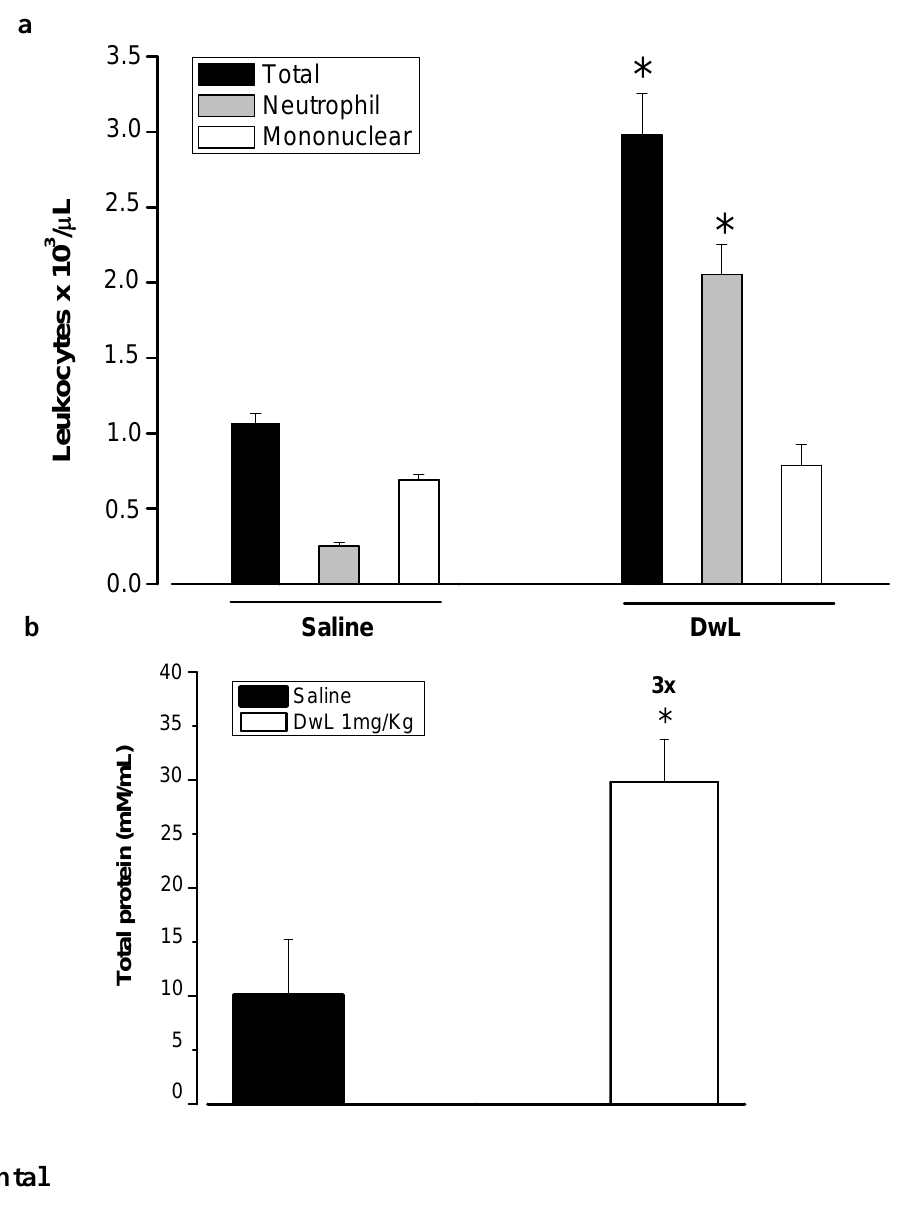
Figure 7. Neutrophil migration induced by lectin from the seeds of Dioclea wilsonii (DwL). DwL (1 mg/Kg) was administered intraperitoneally. Five hours later, the exudates were collected by washing with 10 mL saline containing 5 UI heparin/mL. ( a ) Total and differential cell counts were performed. ( b ) Total protein was quantified (A = 595 nm). Results are mean values ± S.E.M. for each group of 6 animals. * p < 0.05 compared to saline